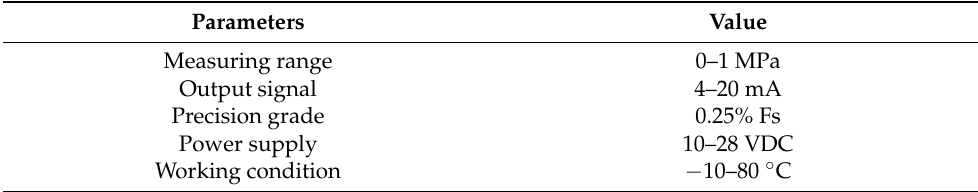
Table 2. The main technical parameters of the pressure sensor.